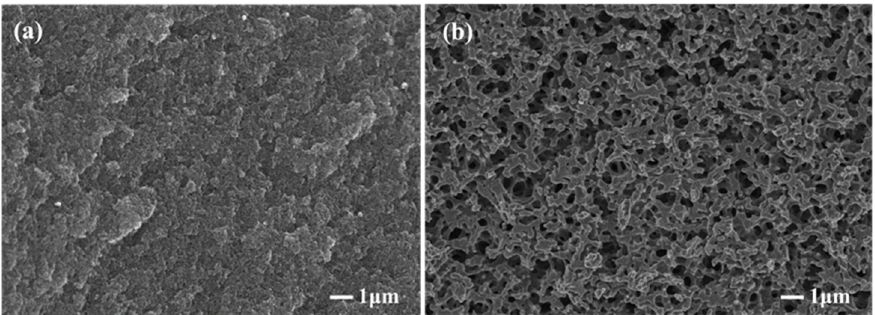
Figure 2. Effect of MgCl 2 on the morphologies of porous carbons ( a ) without MgCl 2 ; ( b ) with MgCl 2 .